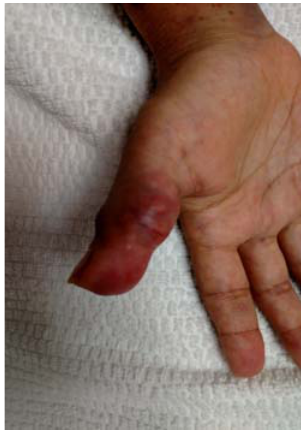
Figure 1: Right thumb lesions.